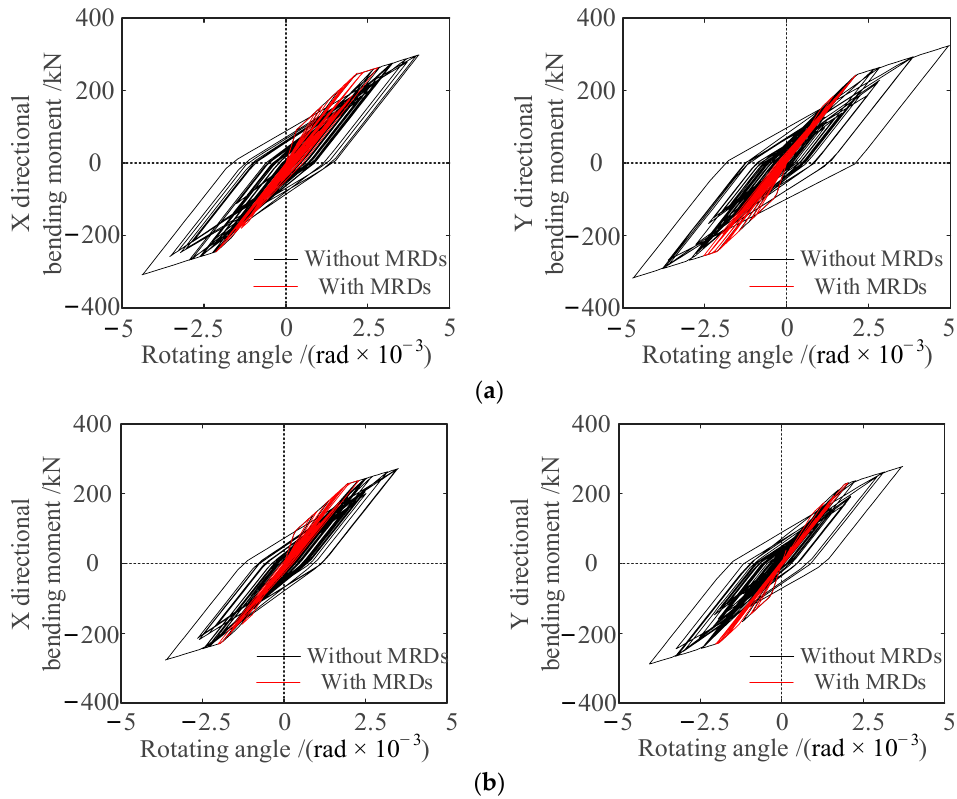
Figure 13. Bending moment-angle hysteresis loops of RC frame structures with and without MRD under Tangshan waves. ( a ) The column in third story; ( b ) the column in fourth story.